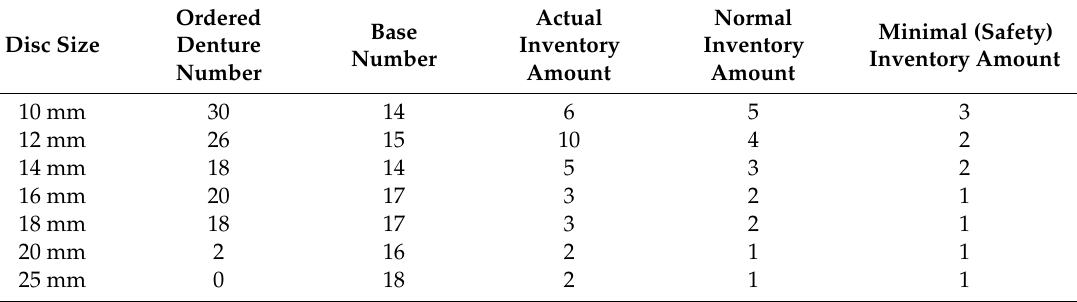
Table 4. Experimental results from the expert